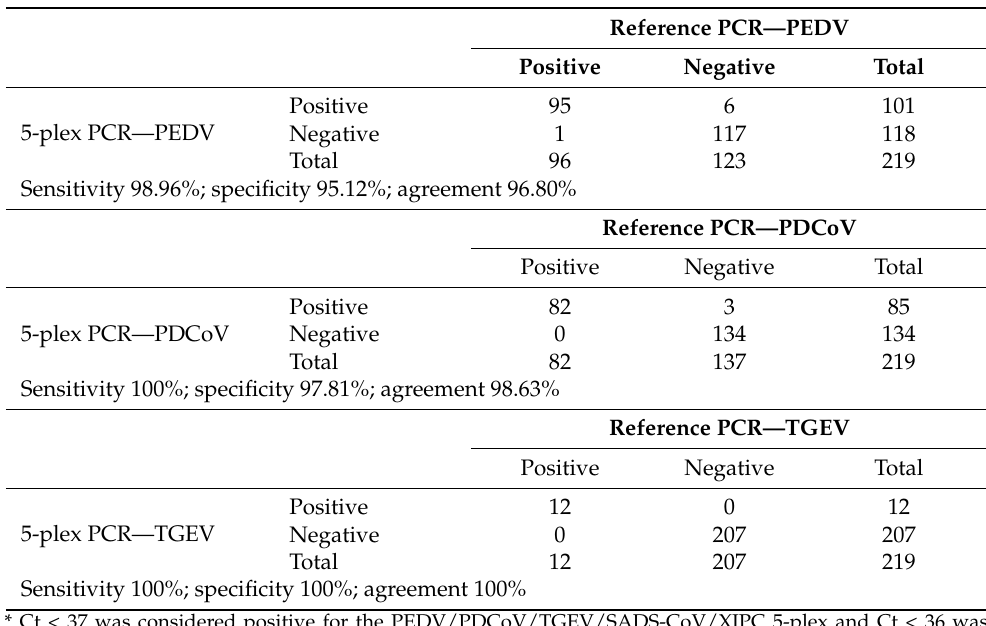
Table 9. Diagnostic performance of PEDV/PDCoV/TGEV/SADS-CoV/XIPC 5-plex PCR in compari- son with the reference PEDV/TGEV/PDCoV PCR on clinical samples *.